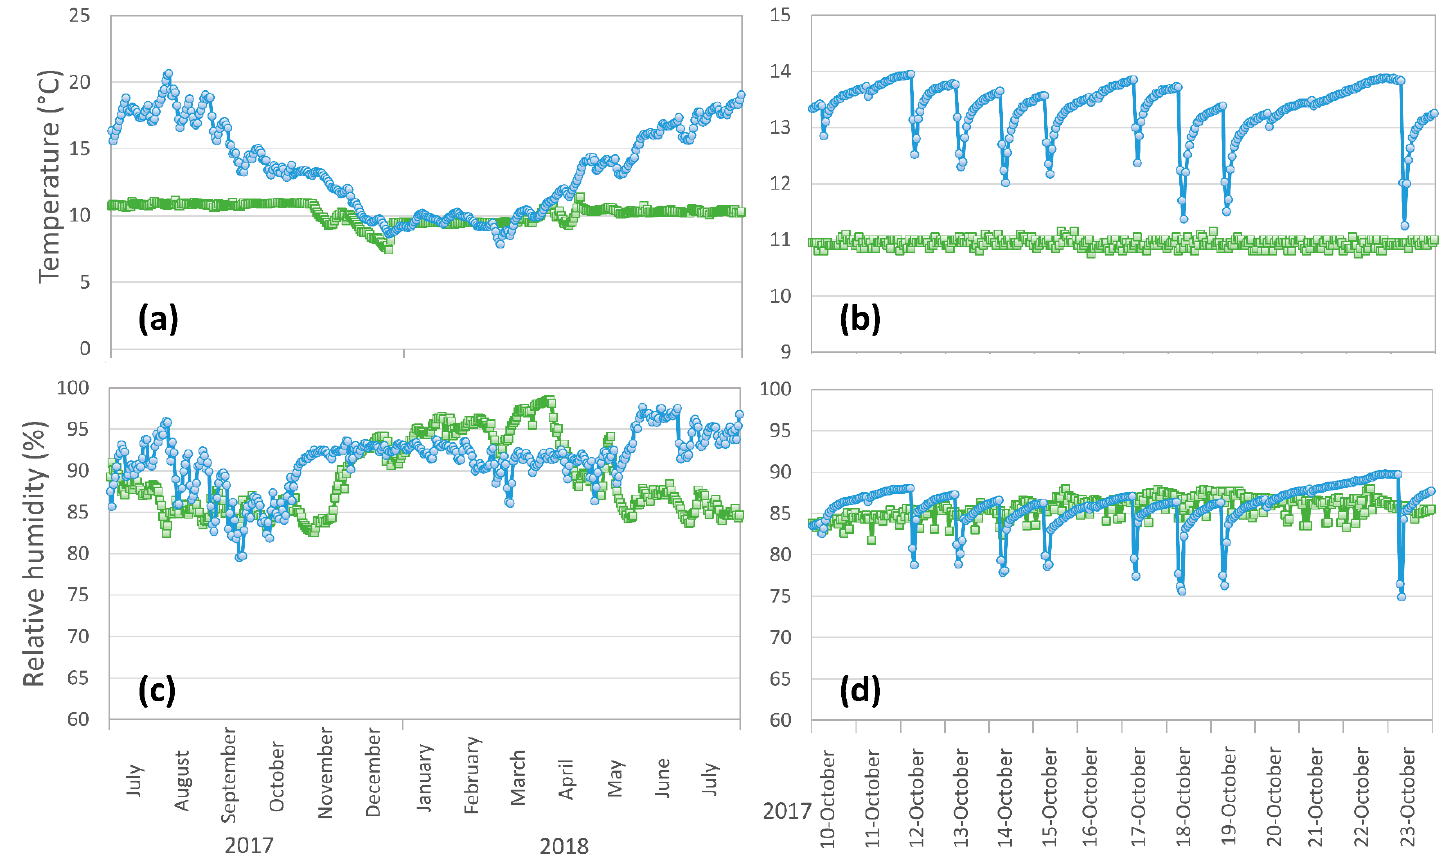
Figure 3. Temperature and relative humidity of Nostrano Valtrompia warehouses: temperature not conditioned warehouse (TNCW) ( ) and temperature conditioned cellar (TCW) ( ). Panels: ( a ) temperature variations over 1 ‐ year ripening period (July 2017–July 2018); ( b ) temperature variations over 2 ‐ week ripening period (10–23 October 2017); ( c ) relative humidity variations over 1 ‐ year ripening period (July 2017–July 2018); ( d ) relative humidity variations over 2 ‐